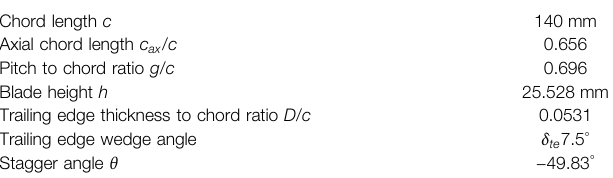
TABLE 1 | VKI CT96 cascade characteristics (Sieverding et al., 2003). Chord length c